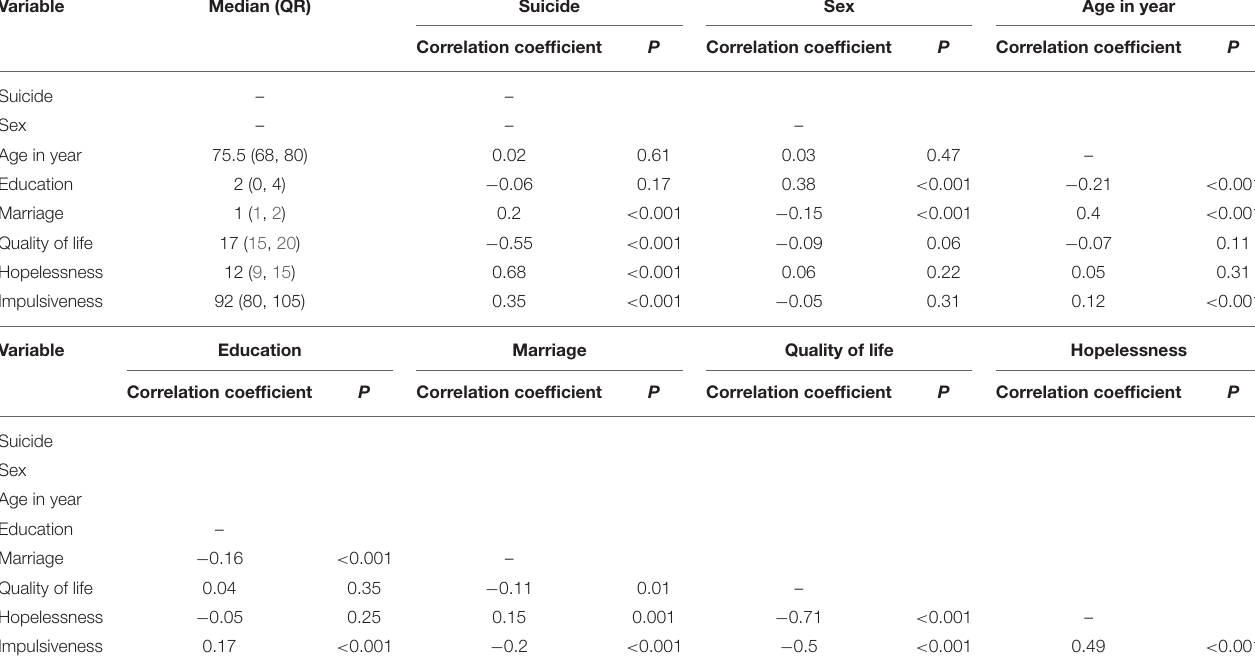
TABLE 2 | The correlation among the variables of the rural elderly.